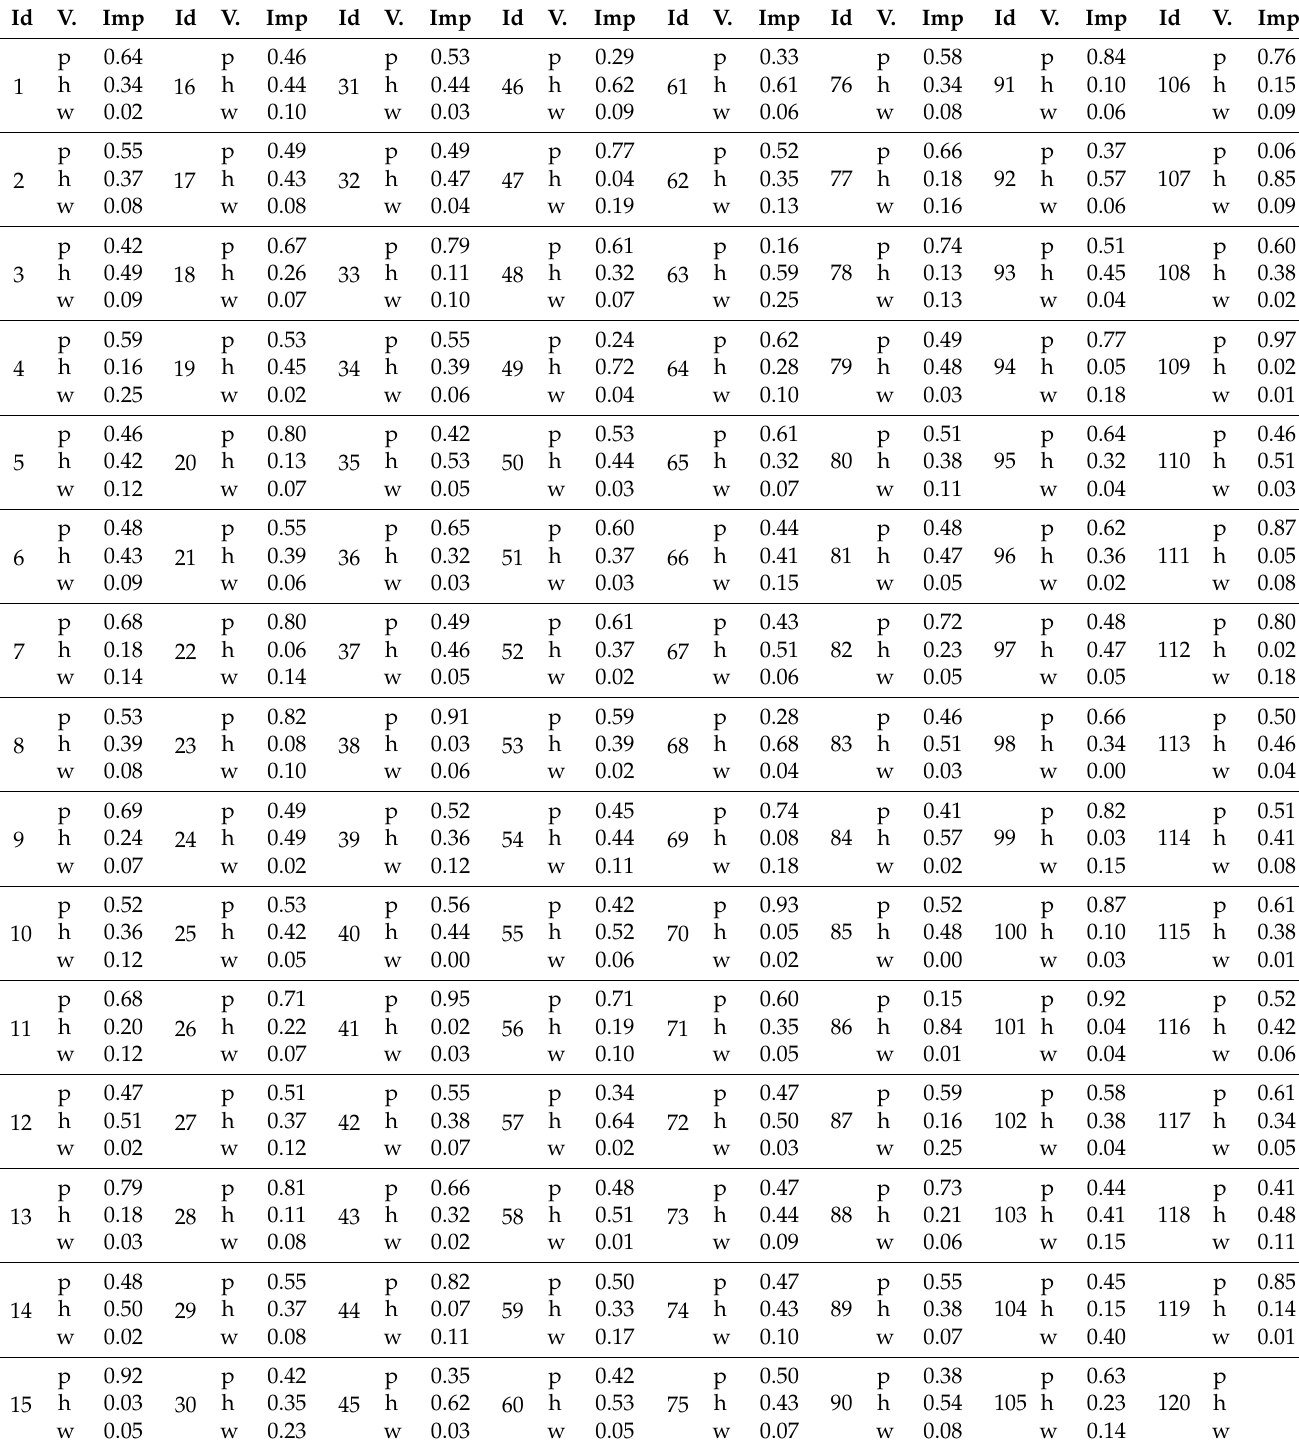
Table 5. Independent variable importance for all the weather stations; Id = code to identify the weather station; V. = independent variable (p, atmospheric pressure; h, relative humidity; w, wind direction); Imp = value of the independent variable